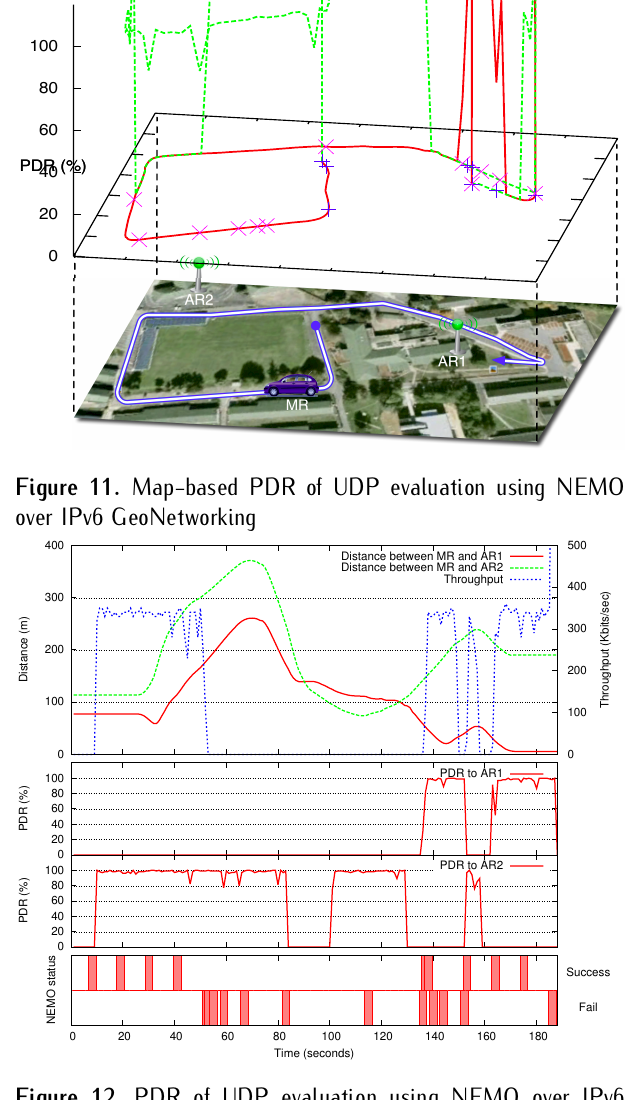
Figure 12. PDR of UDP evaluation using NEMO over IPv6